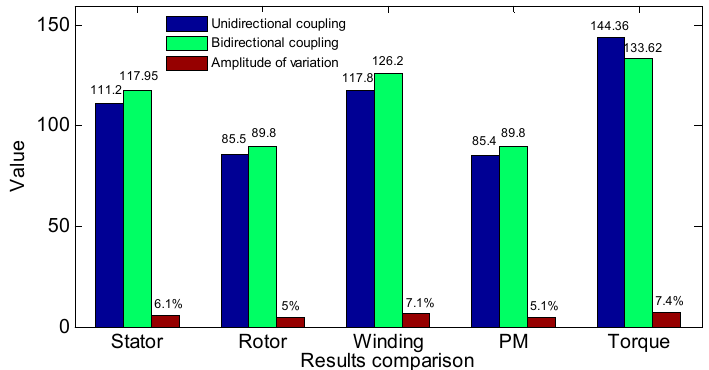
Figure 20. Comparison of torque and maximum temperature of the IWM.